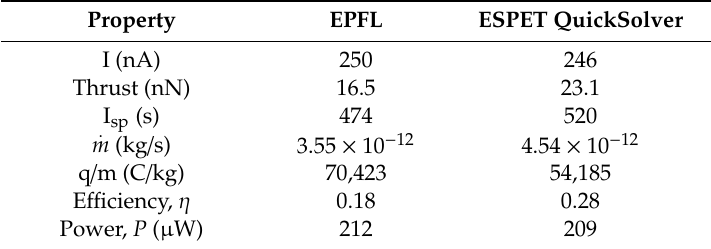
Table 7. Experiment (EPFL) and ESPET comparison including mode switching (emitter average).